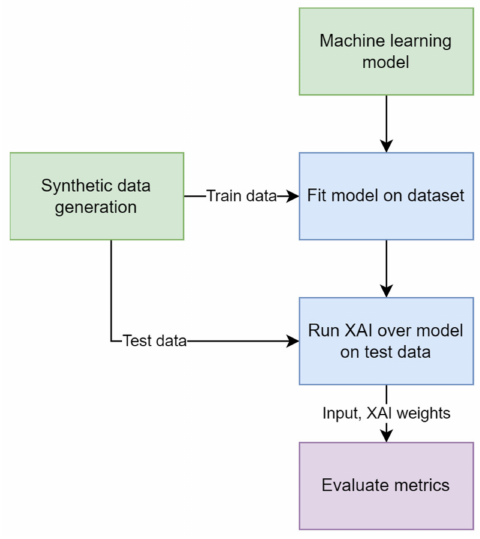
Figure 1. Schematic representation of the method.